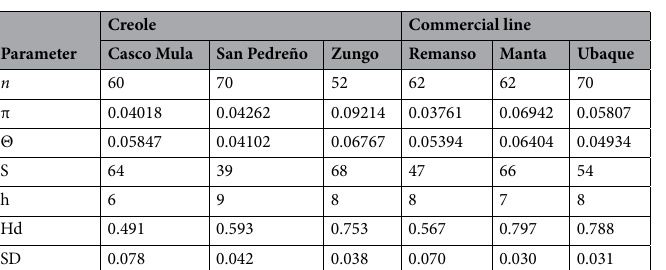
Table 1. Genetic diversity indices for the breeds analysed in this study. n the amount of sequences, π nucleotide diversity, Θ theta (per site) from eta, S the amount of segregating sites, h the amount of haplotypes, Hd haplotype diversity, SD standard